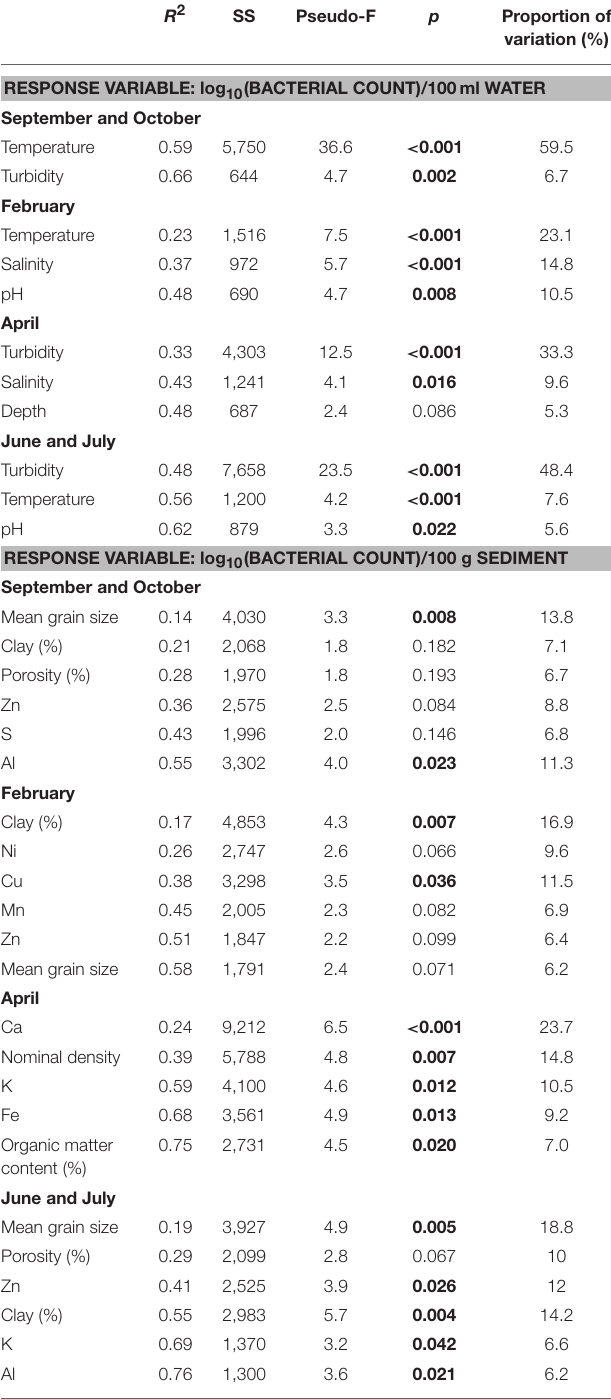
TABLE 1 | Distance Based Linear Models (DistLM) sequential tests. R 2 SS Pseudo-F p Proportion of variation